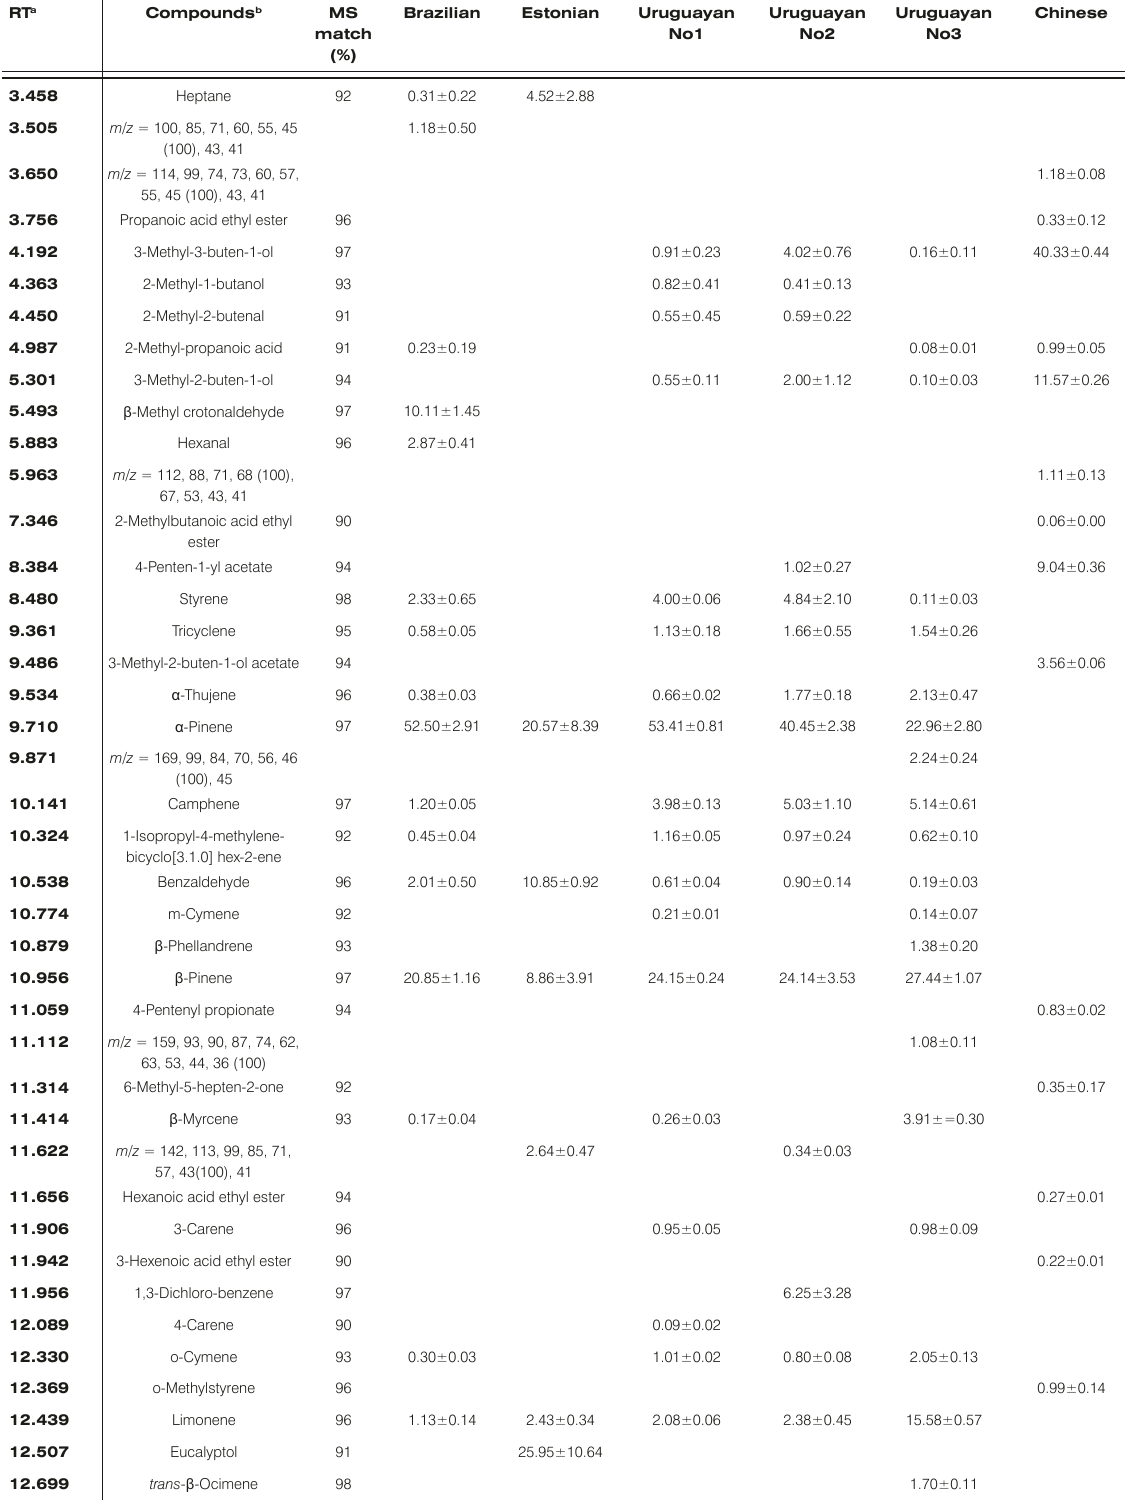
Table 2. The percentage composition of identified volatile compounds in tested propolis samples (the values represent average±standard deviation of six